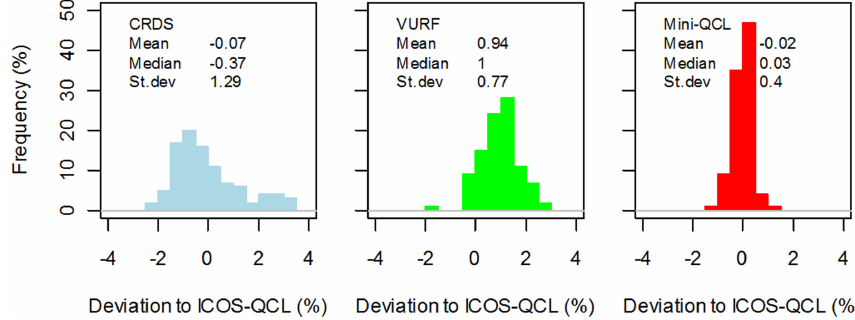
Fig. 14. Histogram of the deviations of the different instruments relative to the ICOS-QCL in per cent during the ambient air